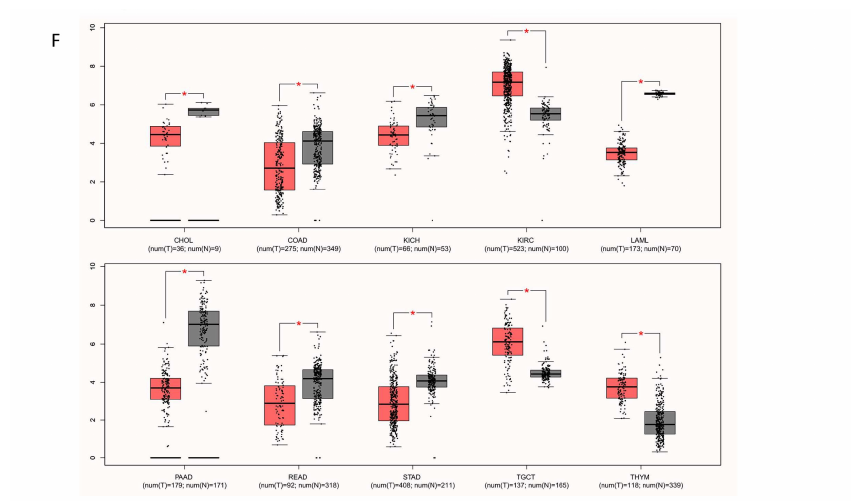
Figure 8. Exploration of the association of tumor metastasis with BNIP3. ( A ) Correlations between BNIP3 and osteosarcoma metastasis are displayed in box plots. ROC curve of diagnosis of osteosar- coma metastasis by BNIP3 in the training set ( B ) and in the entire cohort ( C ). ( D ) Relationship between the expression of BNIP3 and the expression of tumor metastasis-related genes MYC, NELL1, SAR1A, PLOD2, TNFAIP8L1, and TRIM22. ( E , F ) Expression of BNIP3 in different tumors. “*”represented “ p < 0.05”.